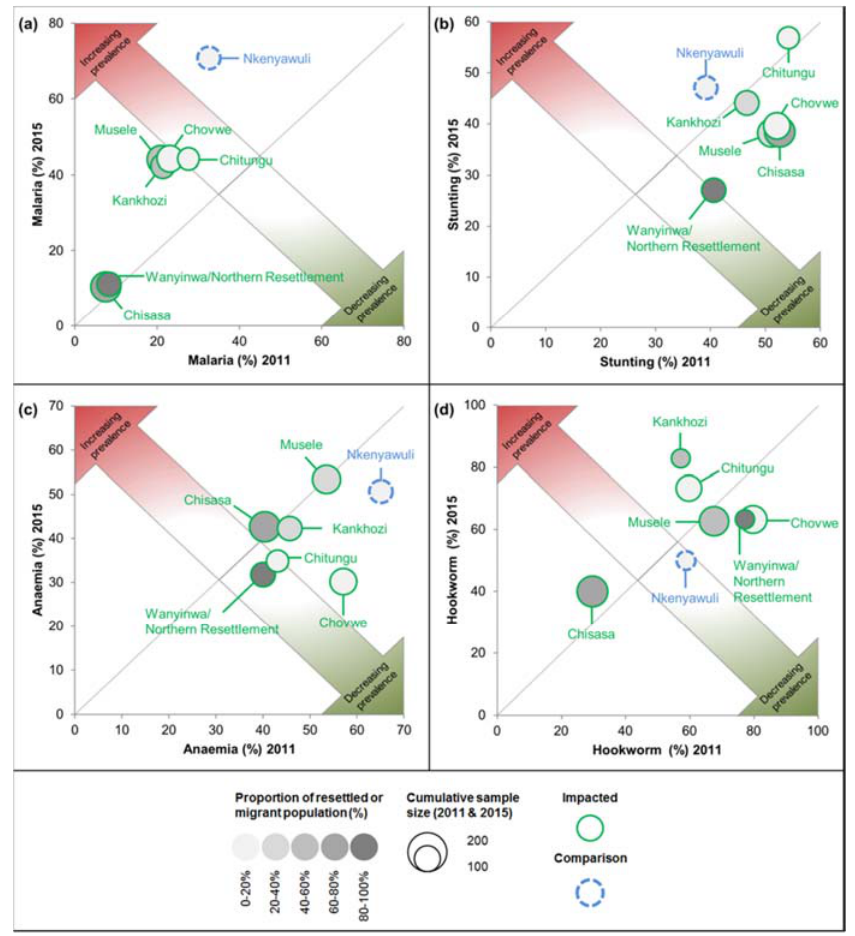
Figure 3. Prevalence rates per sentinel site, Trident project, 2011 and 2015, Zambia: ( a ) prevalence of P . falciparum in children aged 6–59 months; ( b ) prevalence of stunting in children aged 0–59 months; ( c ) prevalence of anaemia in children aged 6–59 months; and ( d ) prevalence of hookworm in children aged 9–14 years.